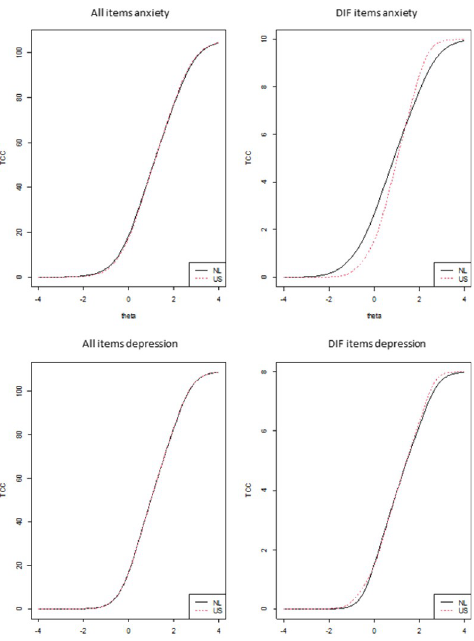
Fig 1. Total impact of DIF on the test characteristic curve (TCC) for anxiety and depression.